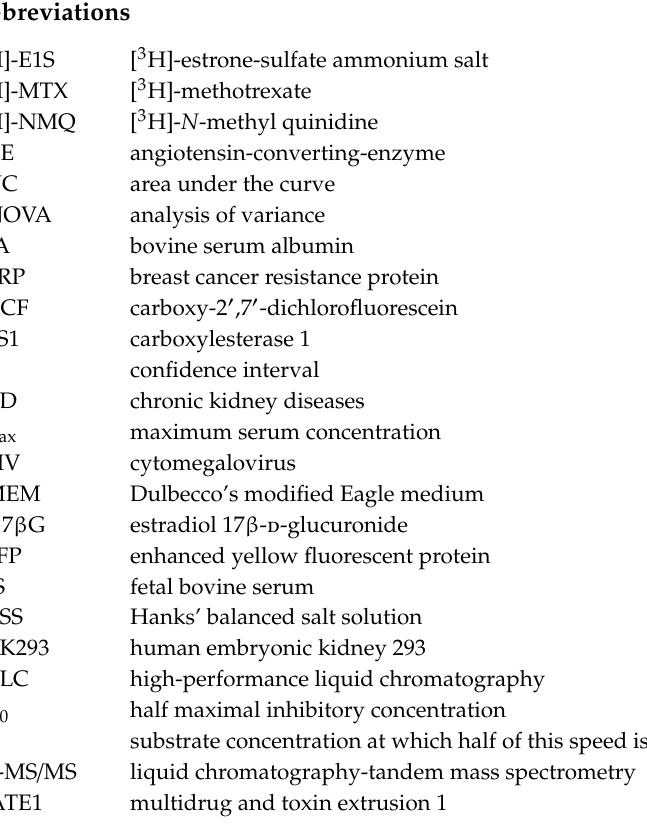
Figure S1: Transporters OAT2, OCTN1, OCTN2, PEPT1, PEPT2 and URAT1 show significant uptake of their model substrate, Figure S2: Concentration response curve for the inhibition of [3H]-E1S uptake by enalaprilat. Figure S3: E ffl ux transporters MRP2, MRP4, P-gp and BCRP did not show transport of